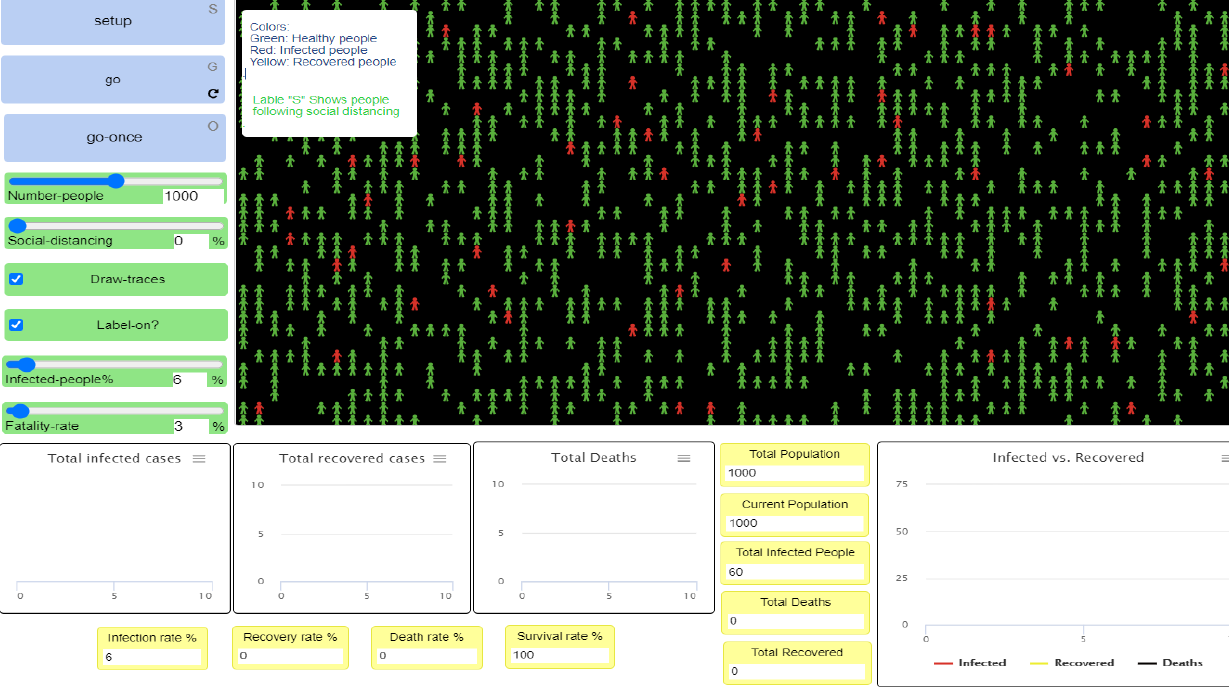
Figure 5. The Netlogo model interface [16].